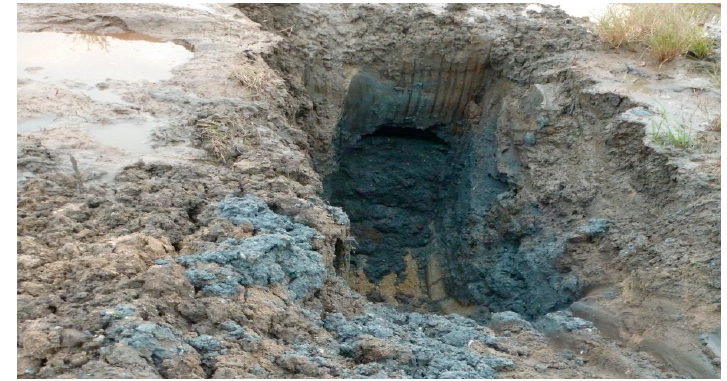
Figure 7. Site excavation of marine soft soil.